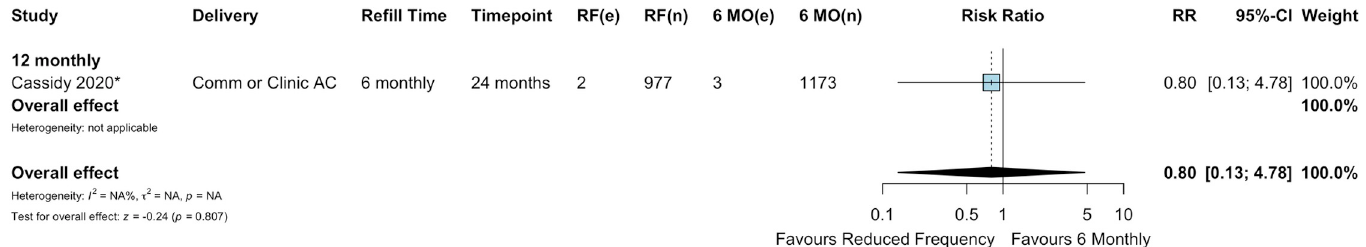
Fig 7. Mortality: Reduced frequency versus 6-monthly clinical consultations. � Cluster-adjusted RR. 6 MO, 6-monthly; AC, adherence club; Comm, community; e, number of events; n, number of participants; RF, reduced frequency; RR, risk ratio.